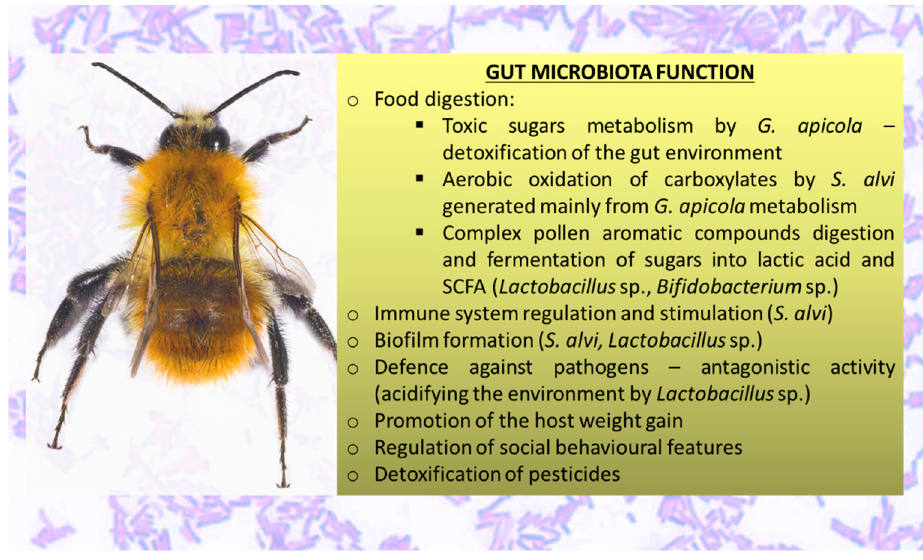
Figure 2. Summary of the main functions of Apis mellifera gut microbiota (references in the text).